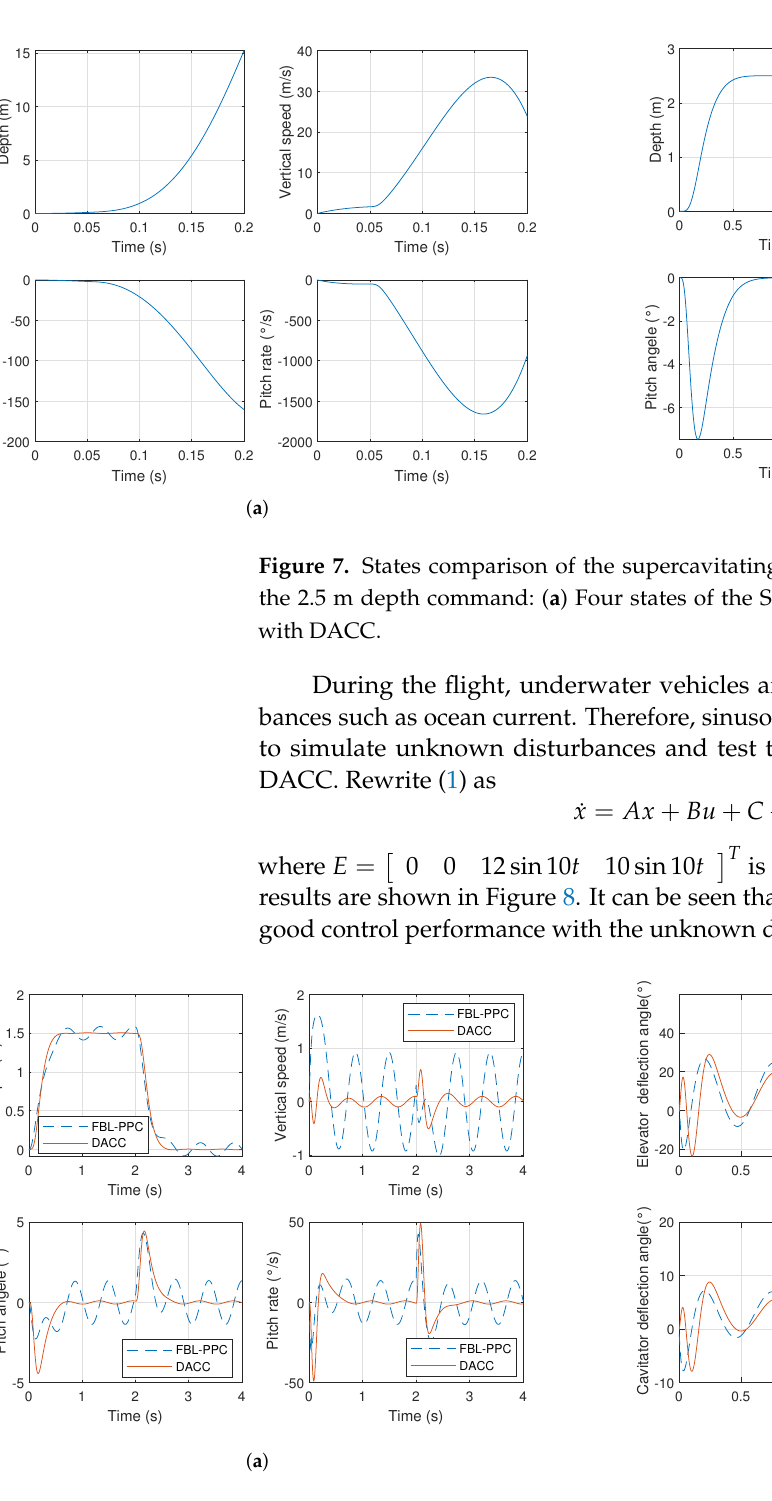
Figure 8. States and actuator deflections comparison of the supercavitating vehicle with the DACC and FBL-PPC under sinusoidal disturbances: ( a ) Four states comparison; ( b ) Actuator deflections